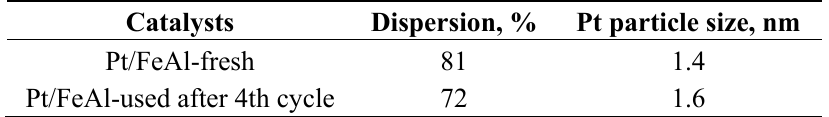
Table 3. Dispersion and particle size of Pt/FeAl fresh and used